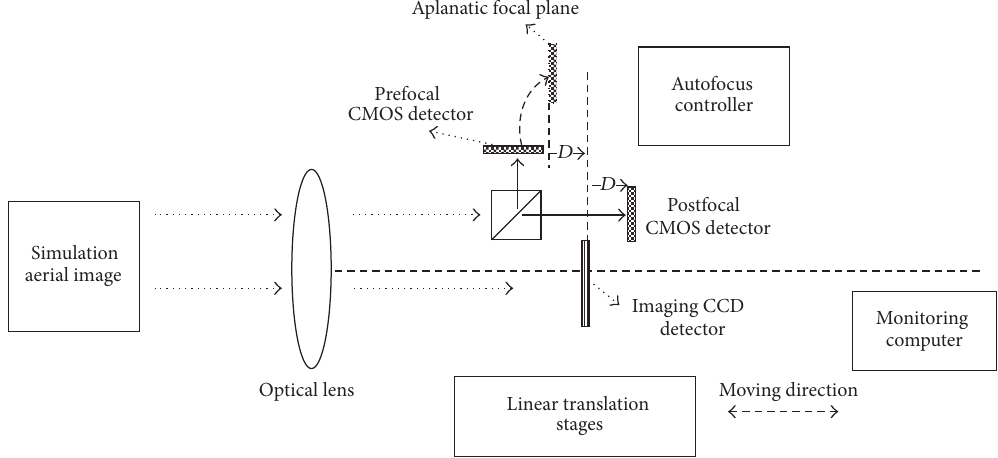
Figure 9: The schematic diagram of autofocusing experiment